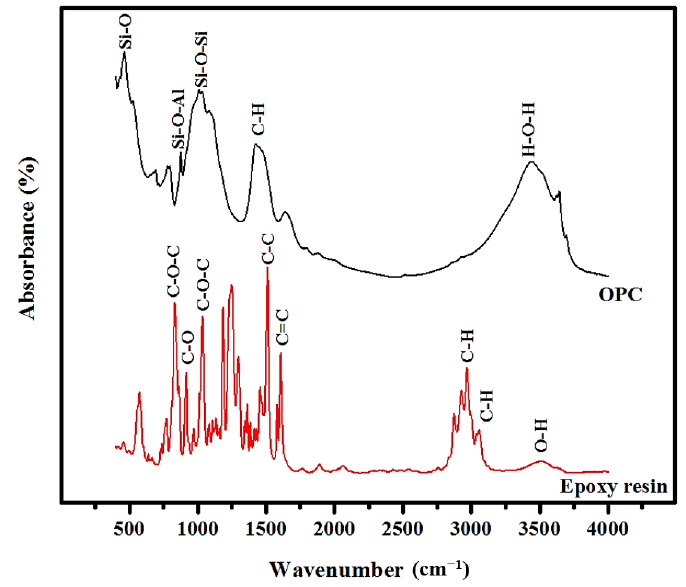
Figure 2. The FTIR spectra of the OPC and epoxy